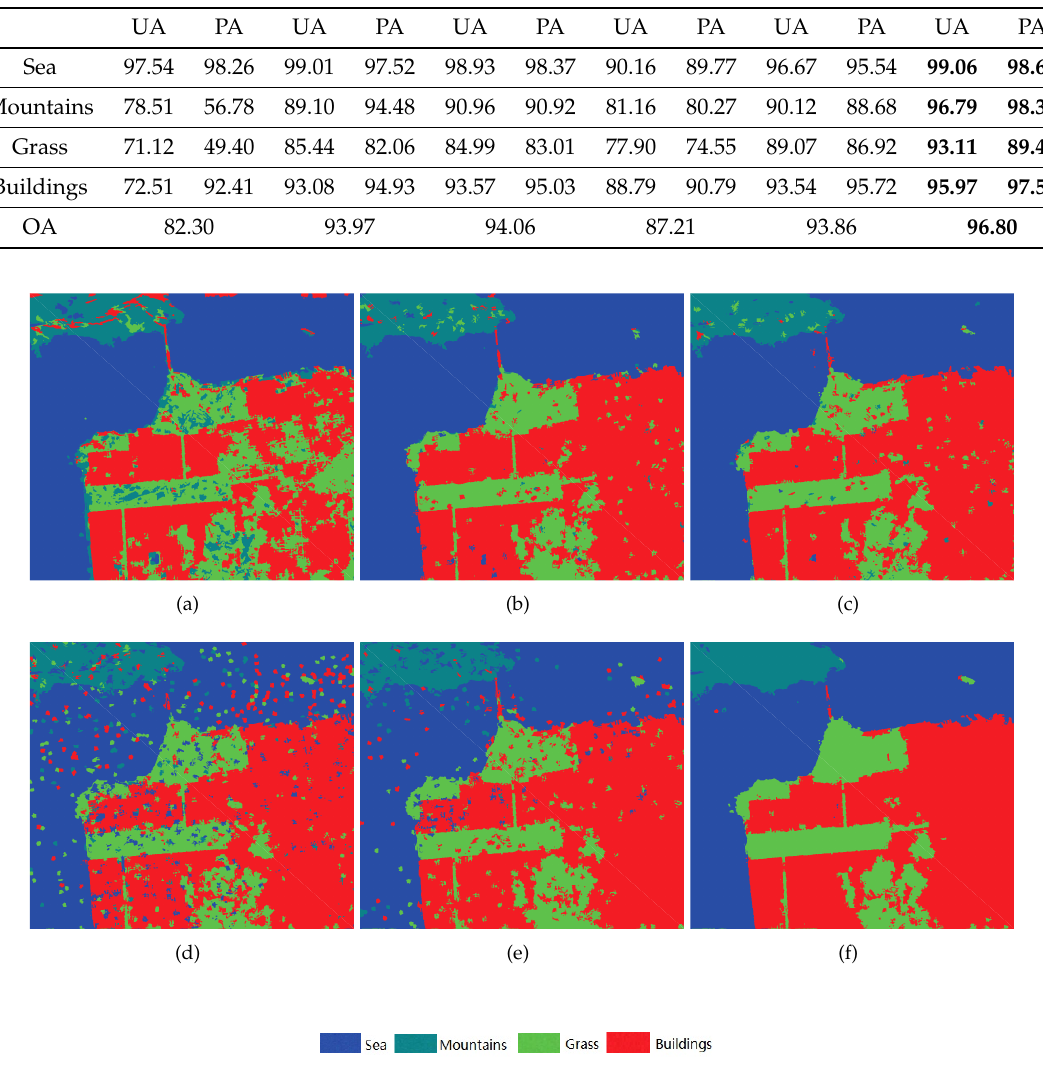
Figure 11. Visual classification results on the San Francisco Bay data set. ( a ) the Wishart classifier, ( b ) LE, ( c ) PCA, ( d ) PFLE, ( e ) WDLE and ( f ) the proposed